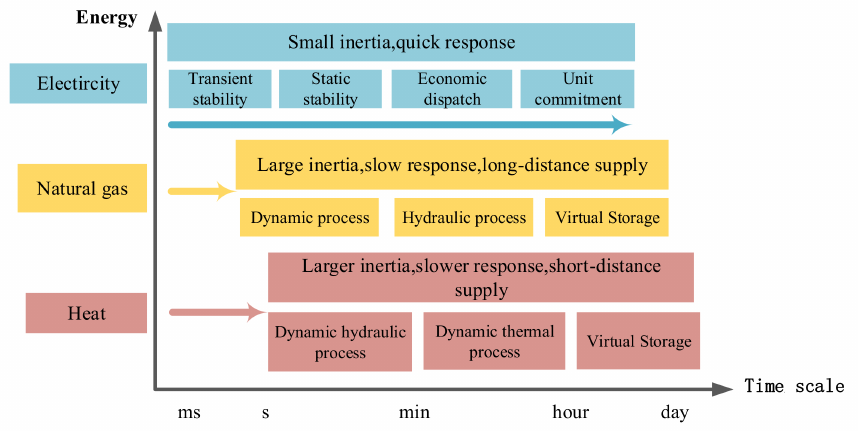
Figure 7. Time-scale characteristics of different energy